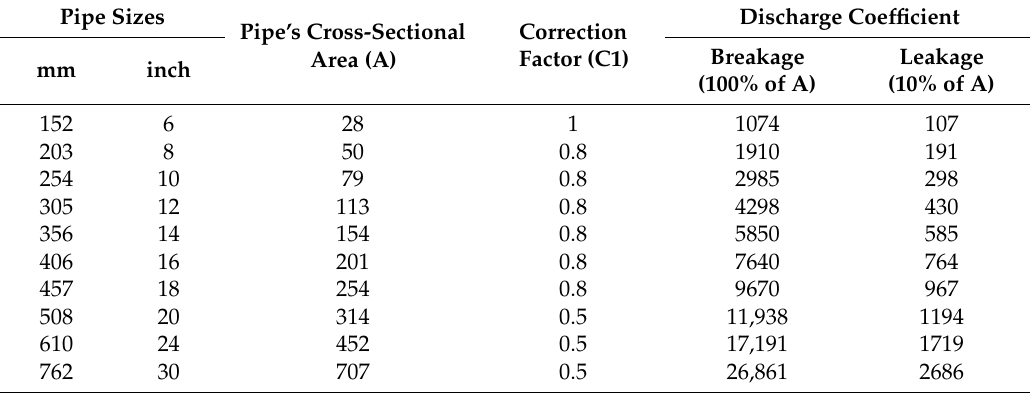
Table 2. Correction factors and discharge coefficients (Equation (6)) for the pipe sizes considered.